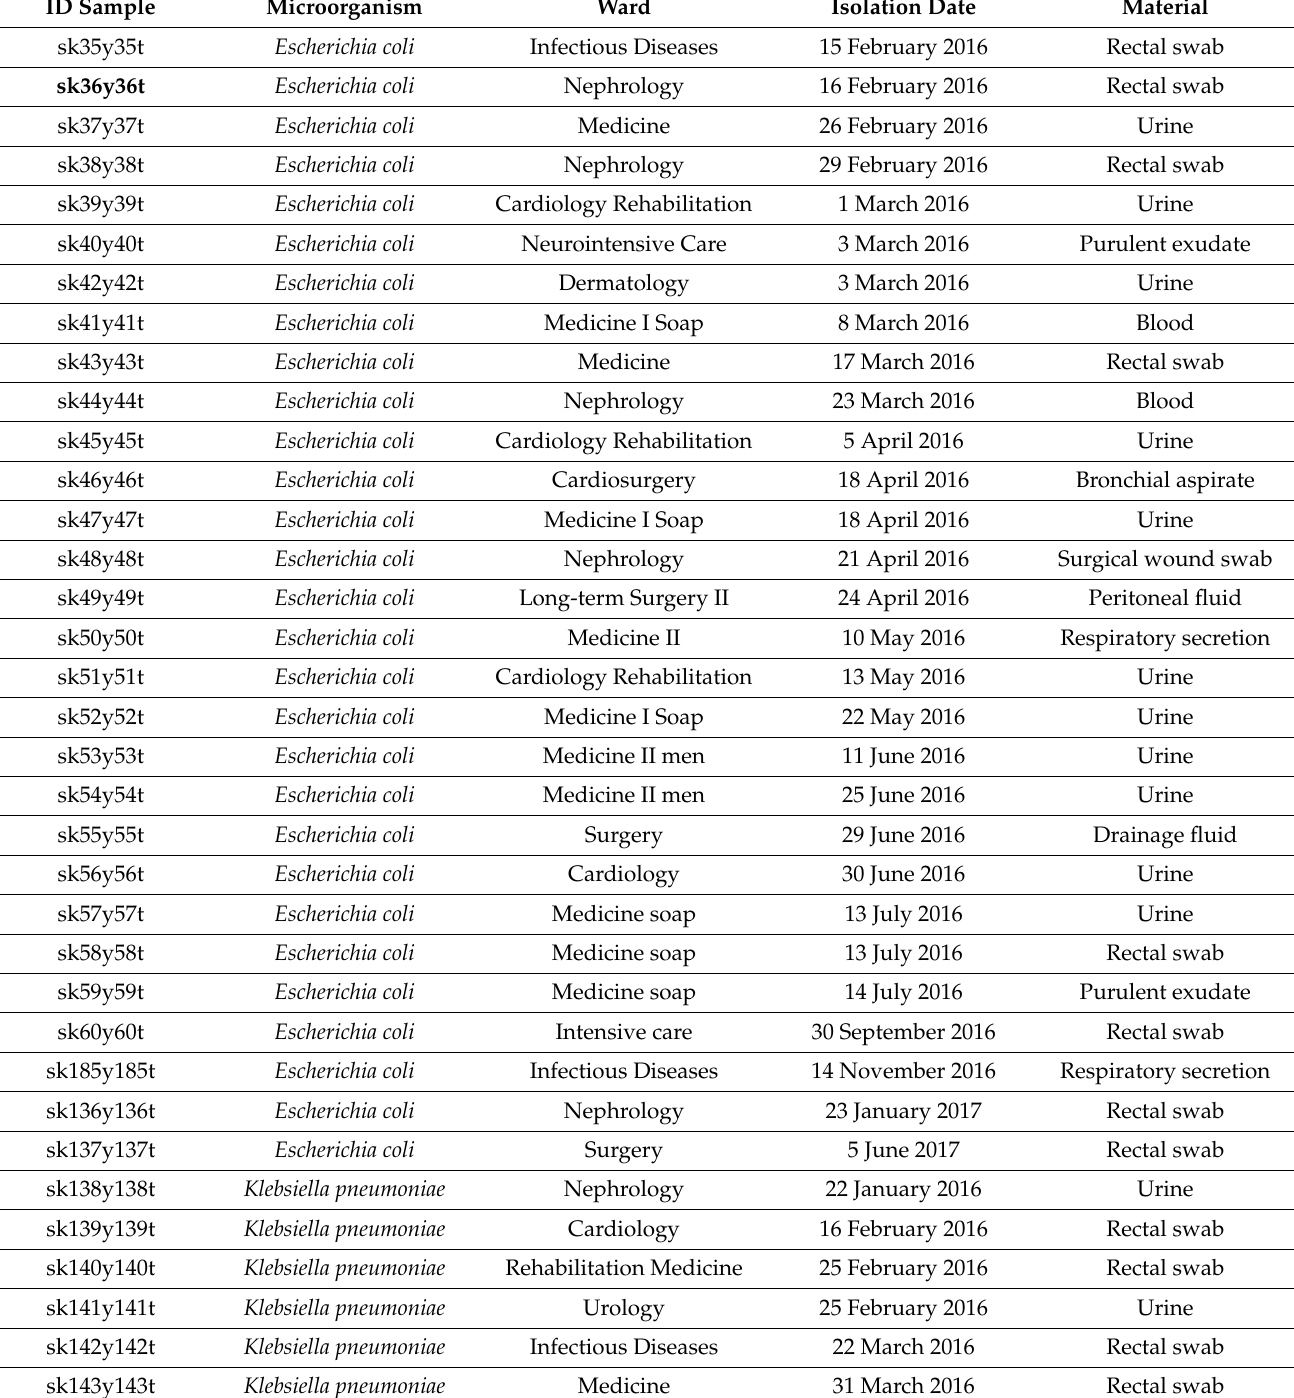
Table 2. Main metadata of the 35 clinical samples included in the study and subjected to whole-genome sequencing. The “index strain” is indicated in